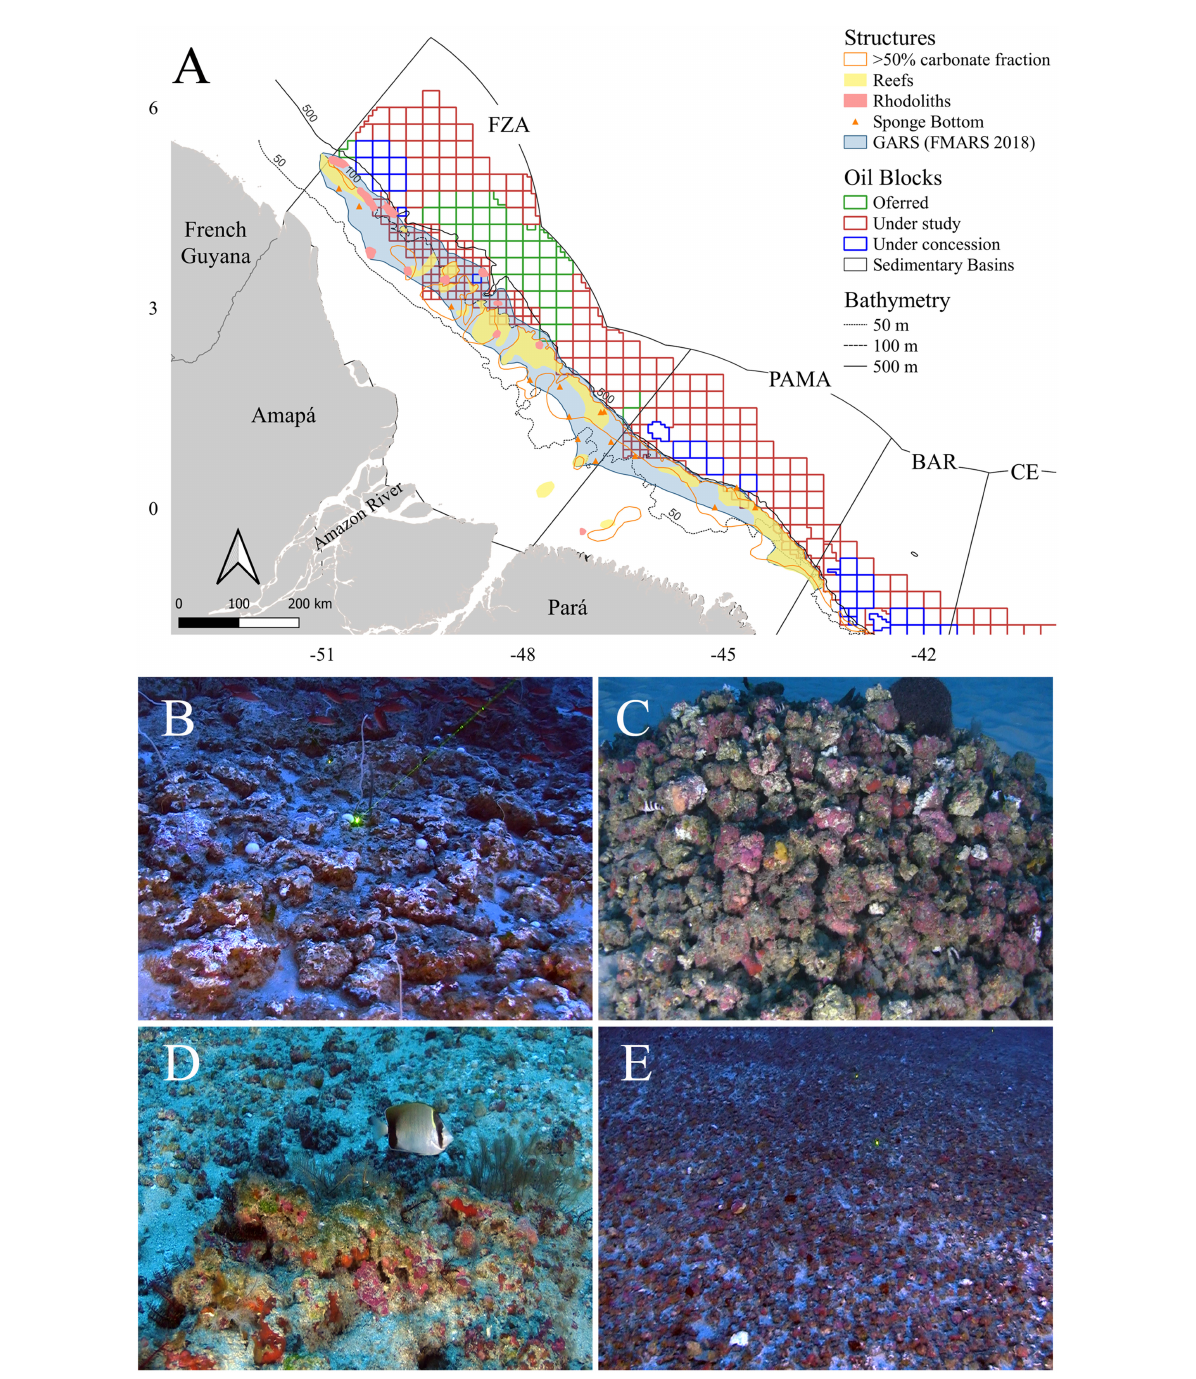
FIGURE 1 (A) The Great Amazon Reef System (GARS), as delimited by Moura et al. (2016) and Francini-Filho et al. (2018), and its overlap with oil blocks. (B) A complex live calcareous algae reef inhabited by fi sh ( Paranthias furcifer ) and black-corals (~130 m depth). (C) A mound built with living rhodoliths by the tile fi sh Malacanthus plumieri (~130 m depth). (D) The reef butter fl y fi sh Chaetodon sedentarius over a calcareous algae patch reef (~110 m depth). (E) A high-vitality rhodolith bed (~140 m depth). Sedimentary basins: FZA, Foz do Amazonas; PAMA, Para ́ /Maranhão; BAR, Barreirinhas; CE, Ceara ́